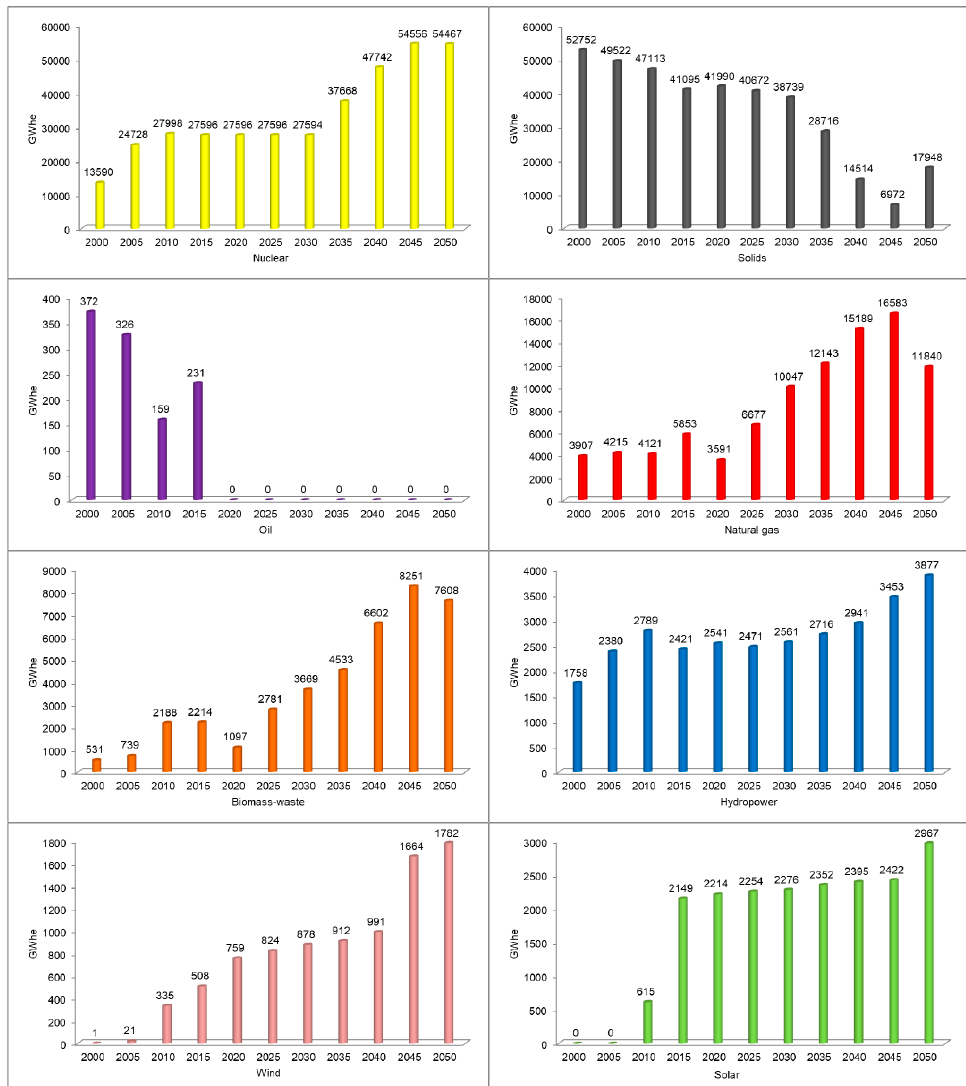
Figure 2. Live cycle inventory data for analysis, based on [34,37].